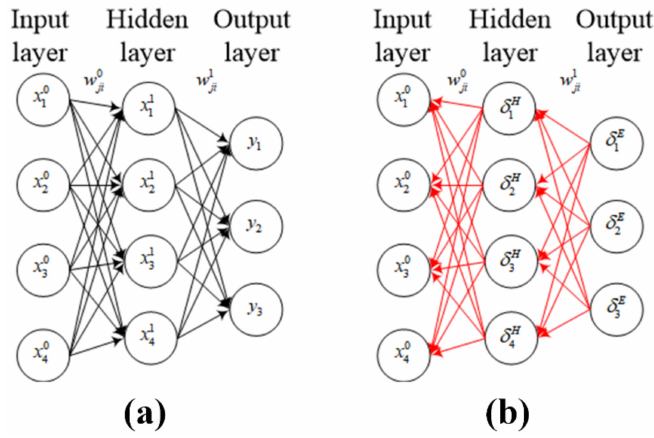
Figure 3. Schematic diagrams of ( a ) feed-forward and ( b ) feed-backward propagation processes of a 2-layer neural